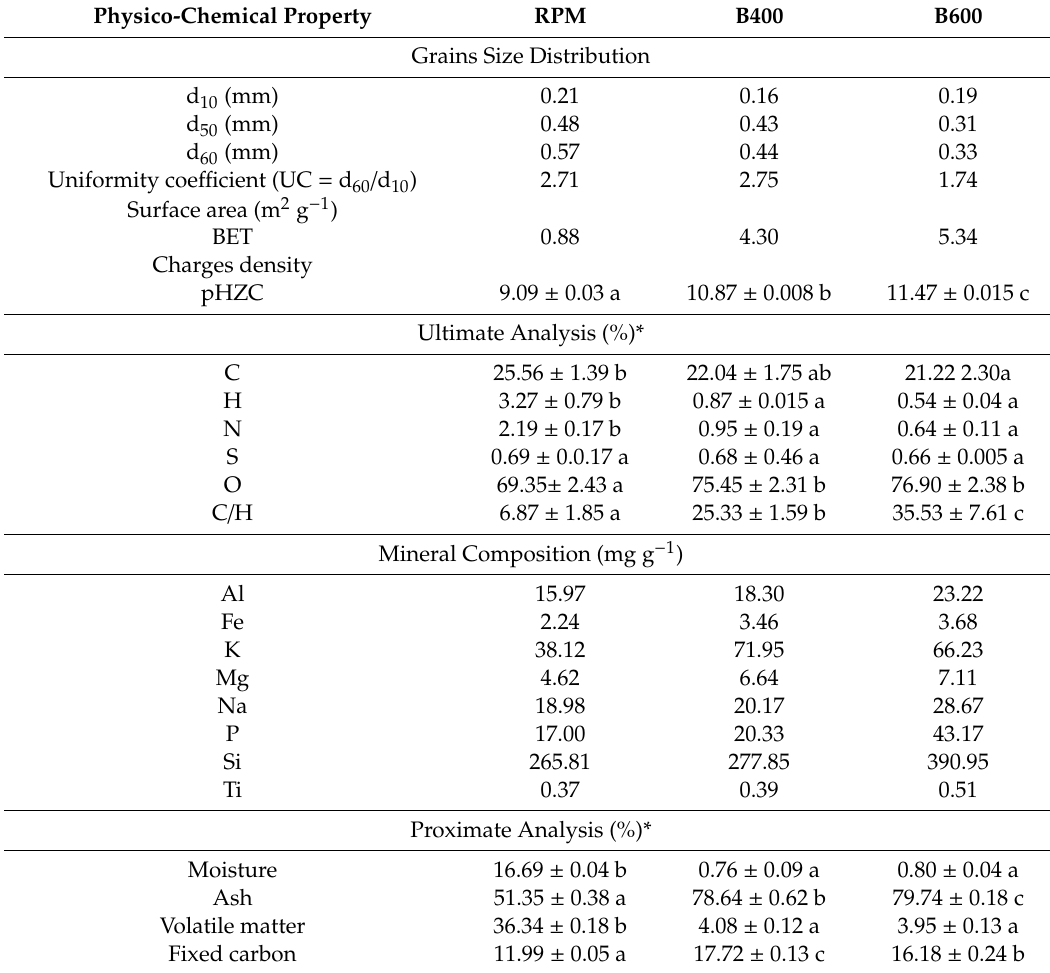
Table 1. Main physico-chemical characteristics of raw poultry manure (RPM), B400, and B600 (*: In Wt.% dry basis). For each parameter, means with the same lowercase letters are not statistically di ff erent at p <